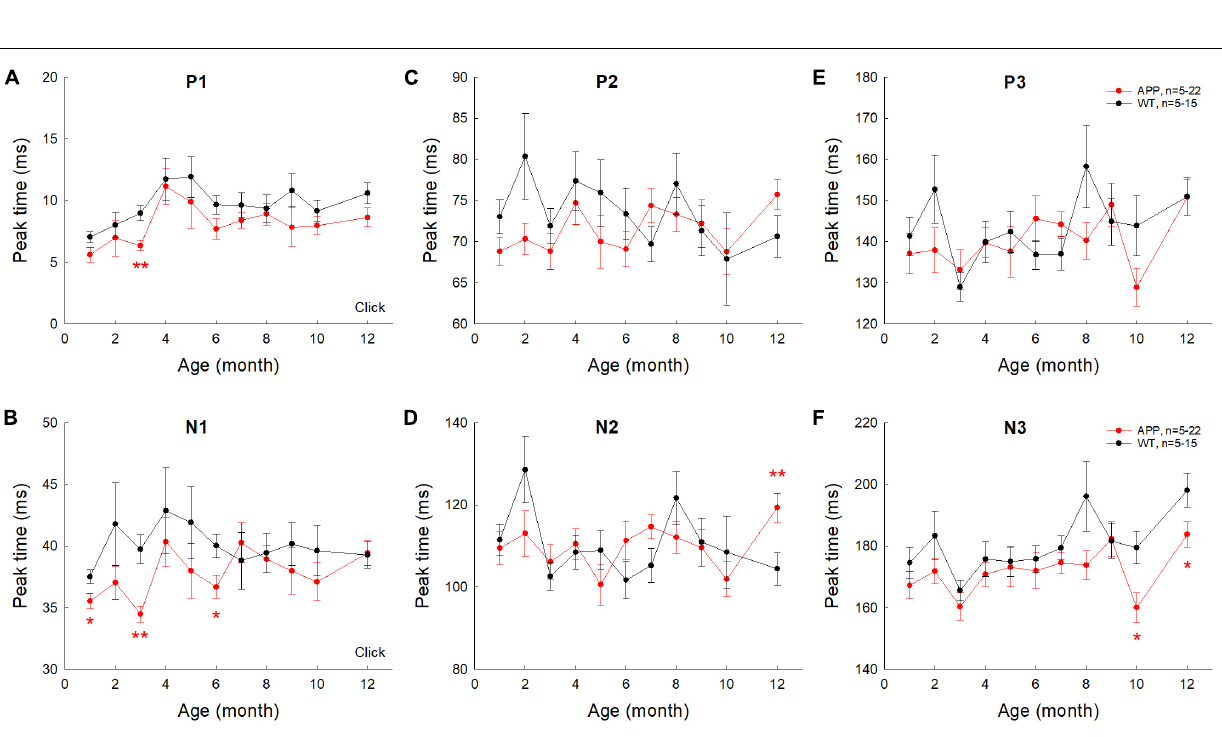
Frontiers in Aging Neuroscience |